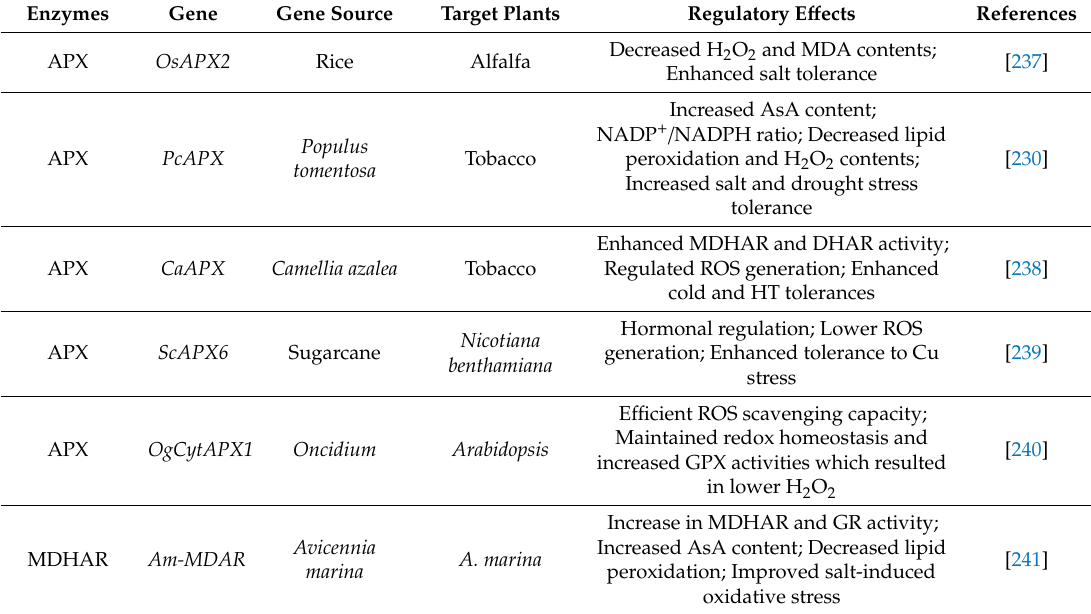
Table 4. Overexpression of genes related to AsA-GSH pathway and their role in ROS scavenging.